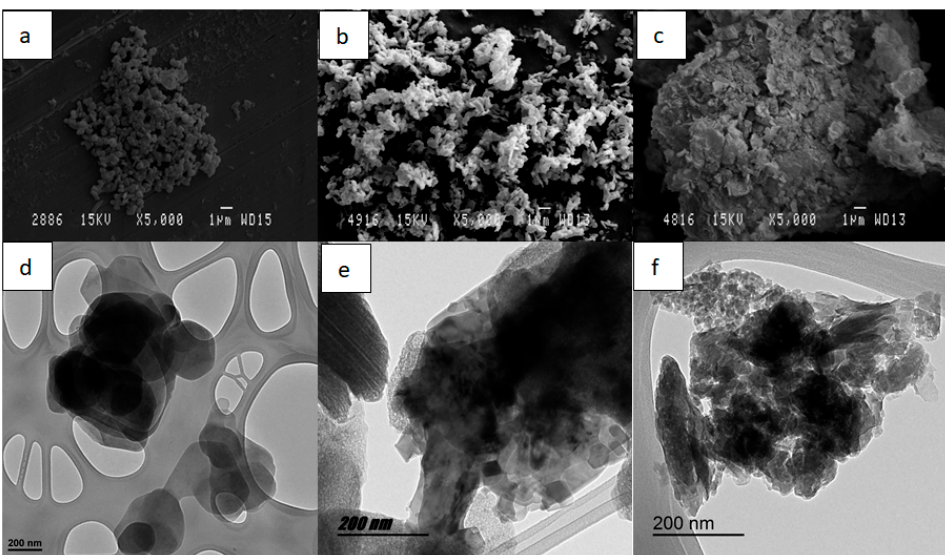
Figure 10. SEM micrographs of different H samples: ( a ) H original ( b ) HC calcinated ( c ) HC reconstructed. TEM micrographs of different H samples: ( d ) H original, ( e ) HC calcinated ( f ) HC reconstructed. Table 6. Lambert-Beer line equations and R 2